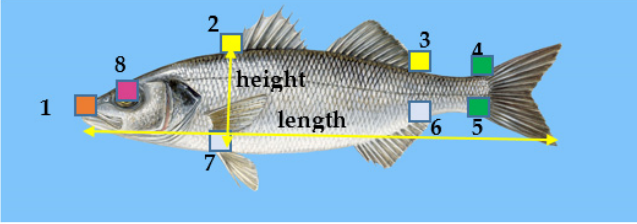
Figure 13. The landmarks used in the deep learning approach.